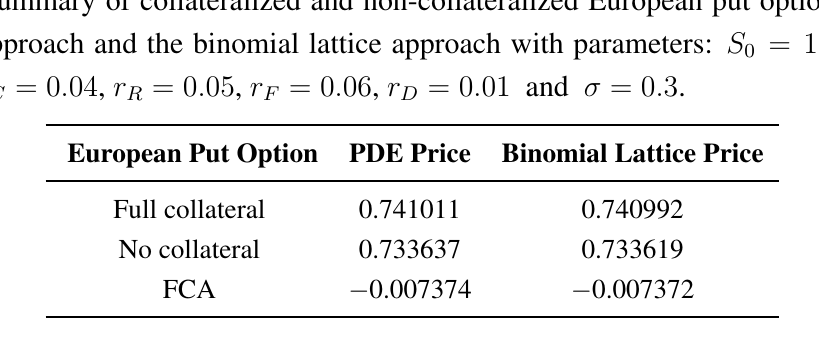
Table 1. Summary of collateralized and non-collateralized European put option prices for the PDE approach and the binomial lattice approach with parameters: S